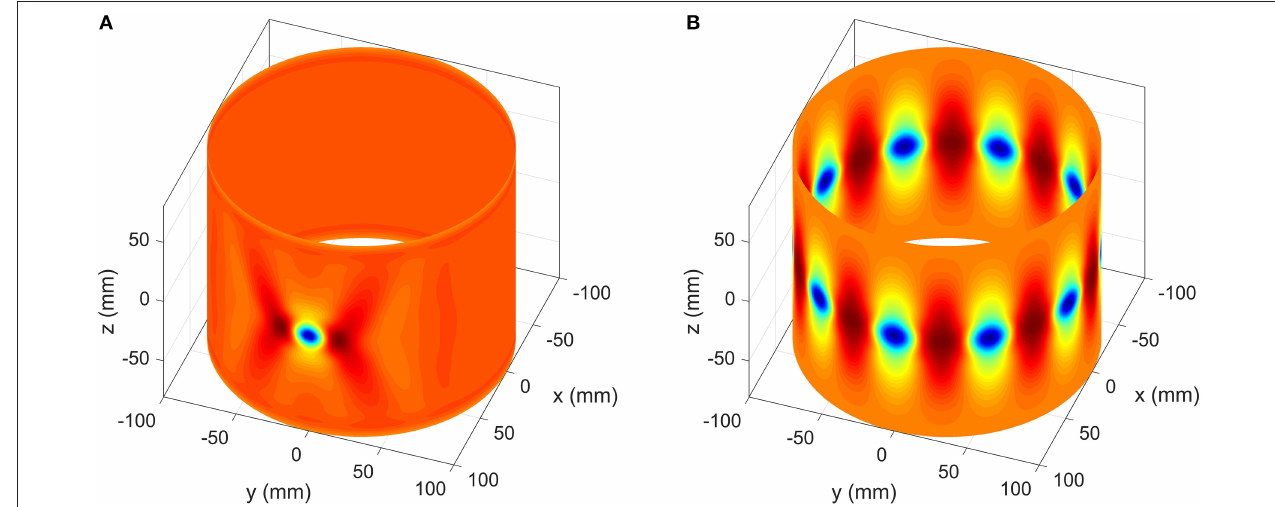
FIGURE 4 | (A) An axially compressed cylinder features an unstable post-buckling equilibrium in the shape of a single inwards dimple, corresponding to the mountain-pass point between the stable pre-buckling and restabilized post-buckling regimes. (B) Through the process described in section 3 the single dimple can multiply circumferentially to form a single row of axially-localized